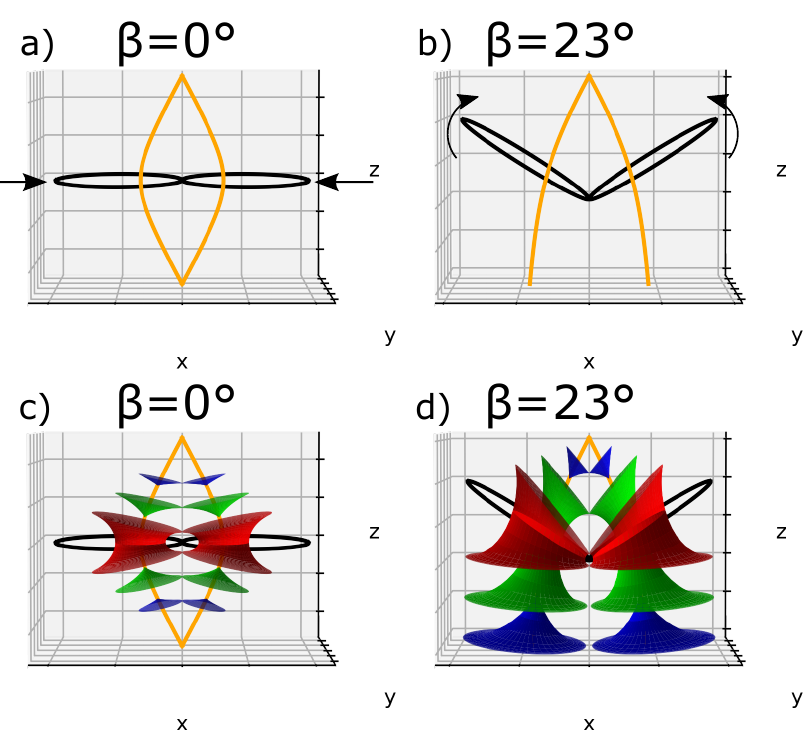
Figure 6. ( a ) The flatten case of two FCDs plot it tangentially according to Friedel’s law (l.c.c.) with their respective vertexes merging at the top. ( b ) the tilted case of the same FCDs with randomly tilt angle β = 23°; ( c , d ) three equidistantly smectic layers corresponding respectively to the flatten and tilted FCDs.